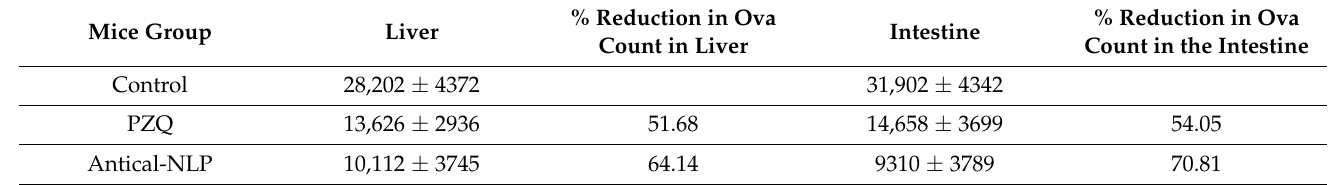
Table 3. Effect of PZQ and anti-calpain-NLP (single dose 250 mg/kg four weeks post infection) on worm load and sex in S. mansoni -infected mice sacrificed six weeks post infection. Table 4. Effect of PZQ and anti-calpain-NLP (single dose 250 mg/kg four weeks post infection) on number of ova/gm tissues in S. mansoni -infected mice sacrificed six weeks post